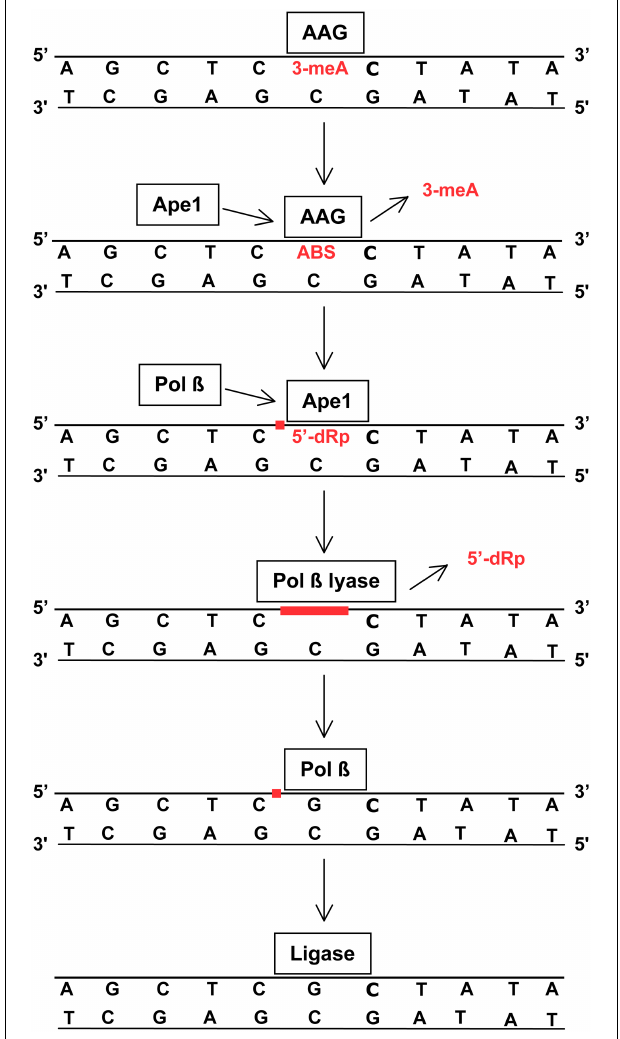
FIGURE 1 | Removal of 3-meA by base excision repair (BER). TMZ-induced 3-meA in DNA is recognized by AGG that excises the methylated base by cleaving the glycosylic linkage between the adducted base and deoxyribose. AAG remains bound to the resulting abasic site (ABS) until displaced by Ape1.The apurinic endonuclease activity of Ape1 incises the DNA phosphodiester backbone immediately 5 (cid:3) to the abasic site, producing a single-strand break (red square) containing a 5 (cid:3) -deoxyribose phosphate (5 (cid:3) -dRP) terminus. Ape1 is replaced by DNA polymerase β (Pol β ) that removes the 5 (cid:3) -dRP via an intrinsic lyase activity to produce a single-nucleotide gap (red line). Using the opposite DNA strand as a template, Pol β then inserts a complementary nucleotide leaving a single-strand break (red square) that is subsequently sealed by DNA ligase.This process is closely coordinated to insure that the potentially lethal abasic sites, and single strand breaks and gaps do not persist. XRCC1 and PARP (not shown) facilitate repair by coordinating protein binding at damage sites. BER is also essential for repair of abasic sites that arise from spontaneous or methylation-enhanced base loss and single-strand breaks produced by ionizing radiation. Some radiation-induced strand breaks contain fragmented or 5 (cid:3) -oxidized deoxyribose moieties that cannot be excised by the lyase activity of Pol β . In this circumstance an alternative BER pathway employs FEN1 endonuclease to excise a two to eight nucleotide long single-strand containing the damage, and the resulting gap is filled by DNA polymerase δ or ε and sealed by DNA ligase (Robertson etal.,